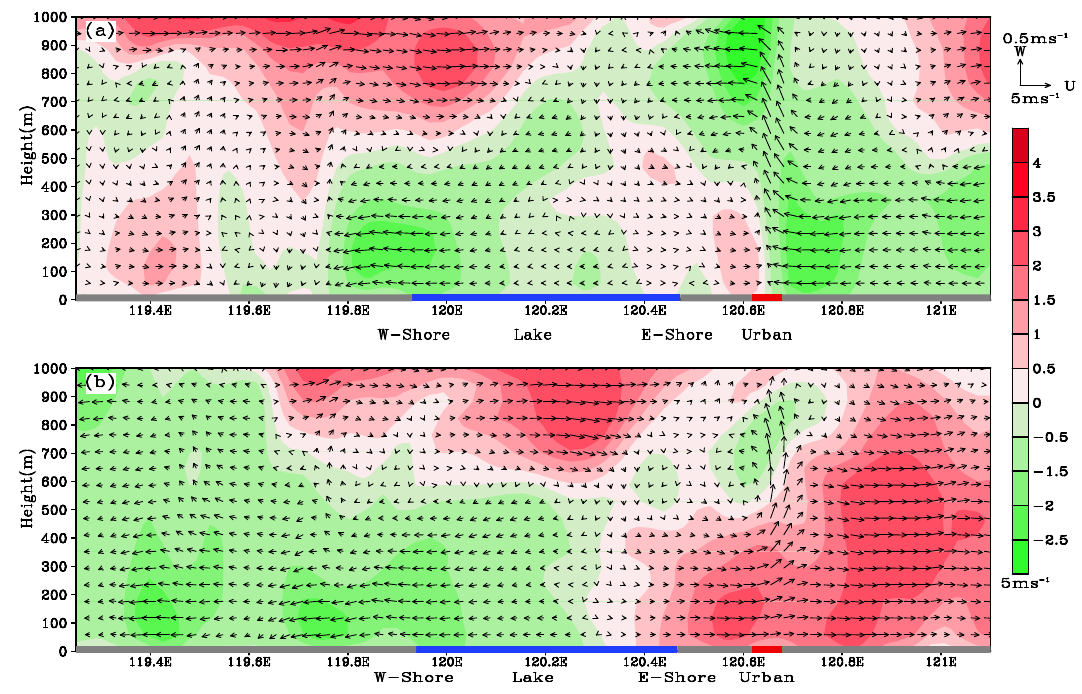
Figure 11. Cross section of wind vector along the center latitude (31.2° N) at 19:00 19 July 2012 by ( a ) S_lake; ( b ) D-Lake.